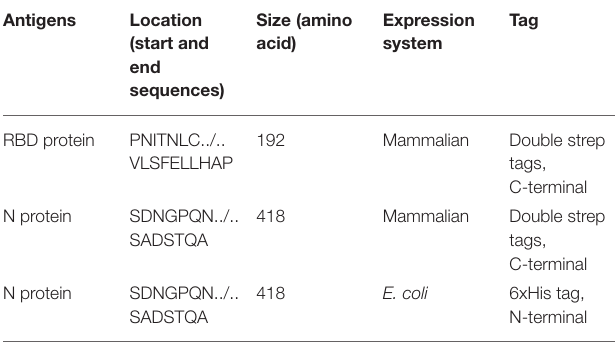
TABLE 1 | SARS-CoV-2 recombinant antigens used in this